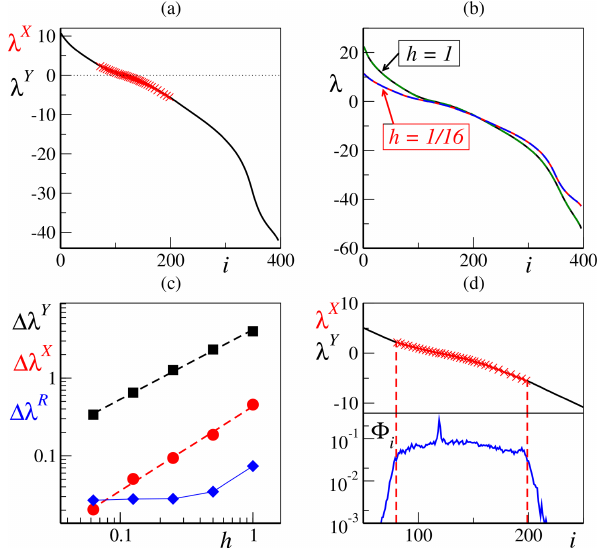
Figure 6. (a) Lyapunov spectra for the uncoupled ( h = 0) case de- composed in its slow ( λ X ; red crosses) and fast ( λ Y ; black solid line) parts. (b) Full Lyapunov spectra (full lines) superimposed with spectra reconstructed from their restricted (see text) counterparts (dashed lines) for h = 1 and h = 1 / 16. (c) Root-mean-squared dif- ference between the finite h restricted spectra and the completely uncoupled fast and slow spectra, for both fast (black squares) and slow (red circles) dynamics. Power law fits (dashed lines) return slopes close to unity (respectively ≈ 0 . 9 and ≈ 1 . 1), suggesting a simple linear growth with the coupling h . Blue diamonds refer to the root-mean-square difference (cid:49)λ R between the full LS and the reconstructed ones in the restricted tangent-space approximation. Both axes are represented in a double logarithmic scale. In the up- per part of (d) is an enlarged view of the central part ( i ∈ [ 50 , 250 ] of the restricted spectra for h = 1 / 8, with the slow ( λ X , red crosses) and fast ( λ Y , black solid line) components differently marked. In the lower part of the panel is the same enlarged view of the h = 1 / 8 projection norm, as computed from the fully coupled dynamics. The vertical red dashed lines mark the upper ( i L ) and lower ( i R ) bound- aries of the superposition region as reported in Table 1. In all panels, we have fixed the following: b = 10, K = 36 and J =